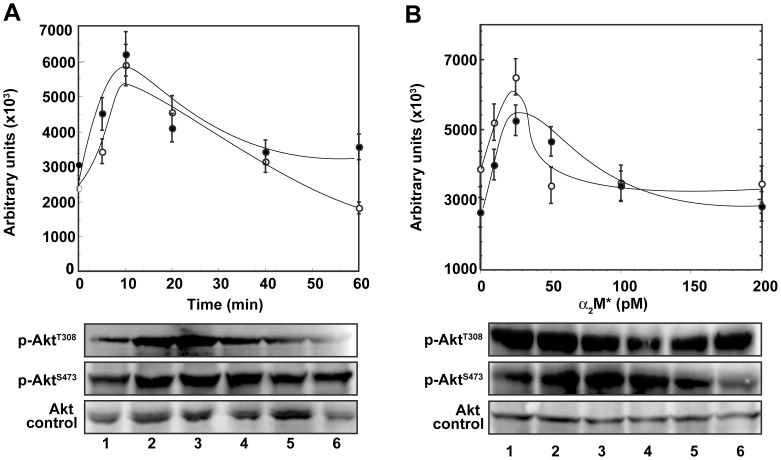
Effect of treatment of 1-LN prostate cancer cells with α2M* (50 pM) for varying periods of time (Panel A) or concentration (Panel B) on expression of p-AktT308 (O) and p-AktS473 (•) as determined by Western blotting. A representative immunoblot of p-AktT308 and p-AktS473 of three to four experiments is shown below the graph. The expression of these proteins is shown in arbitrary fluorescence units and is expressed as the mean ± SE from three to four experiments. The protein loading controls for Panel A and Panel B are shown below the respective immunoblots.